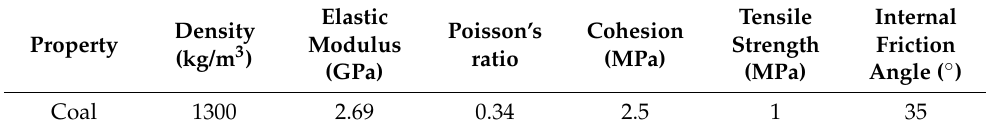
Table 1. The coal mechanical parameters.